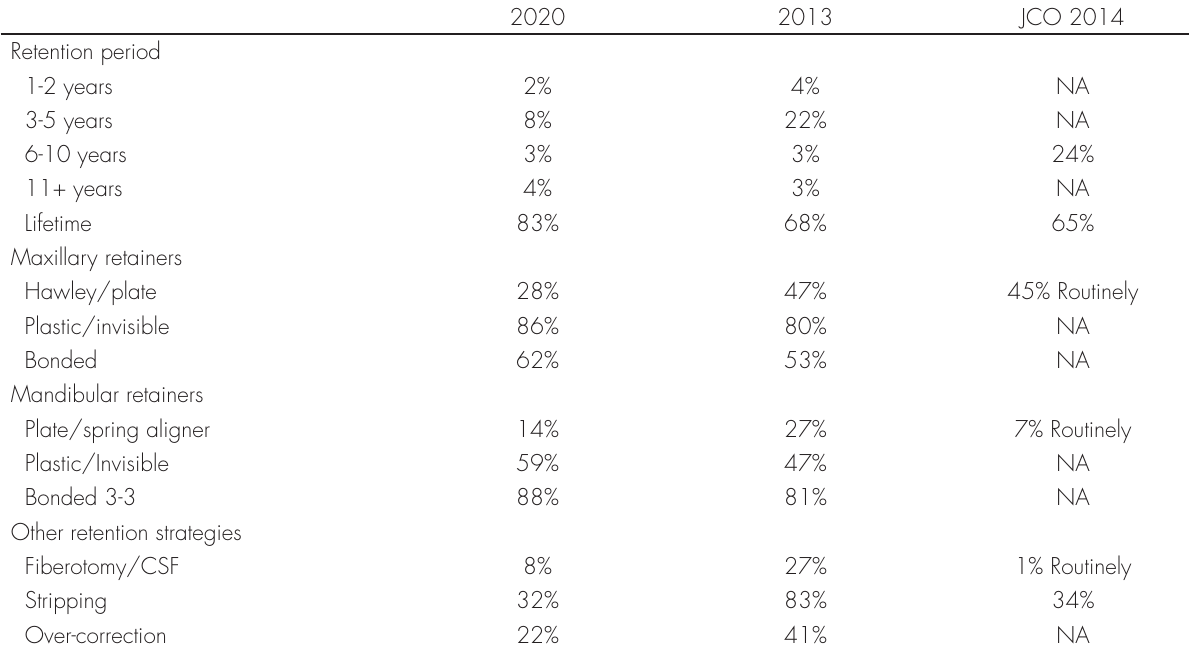
Table VI. Retention